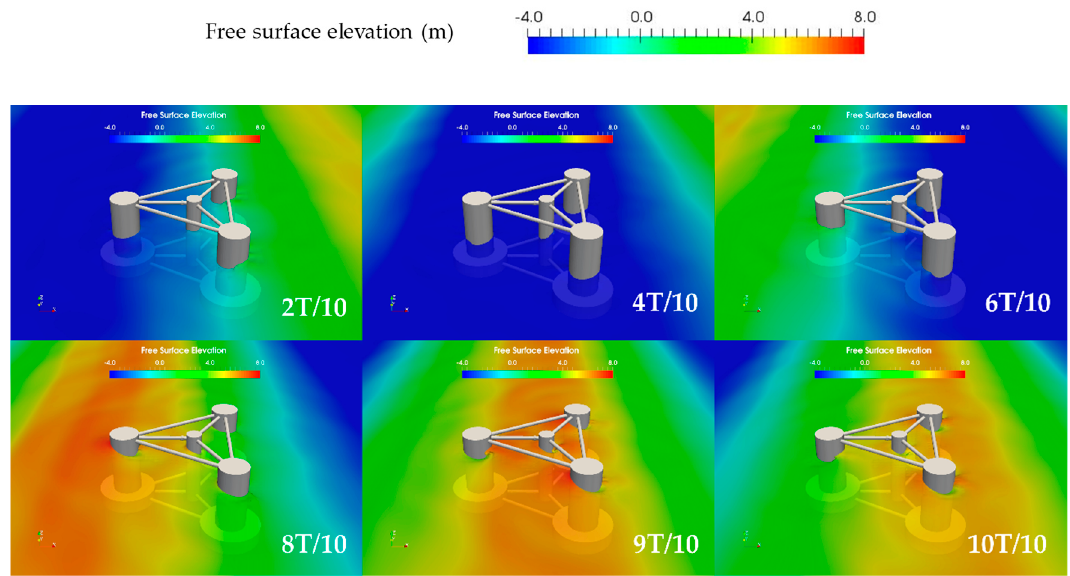
Figure 17. Wave elevation contour plots around a fixed semi-submersible platform under regular wave ( H = 14.7 m, T = 15.0